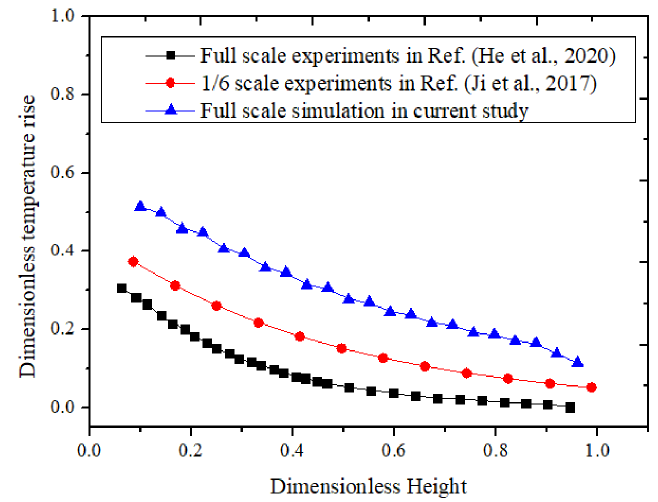
Figure 2. Vertical temperature distributions inside the staircase at 0 m/s.